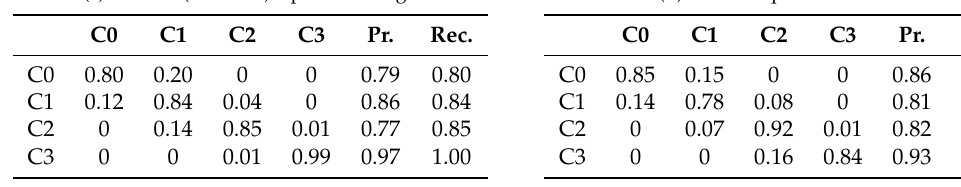
# images/ mm punch movement). ± ±